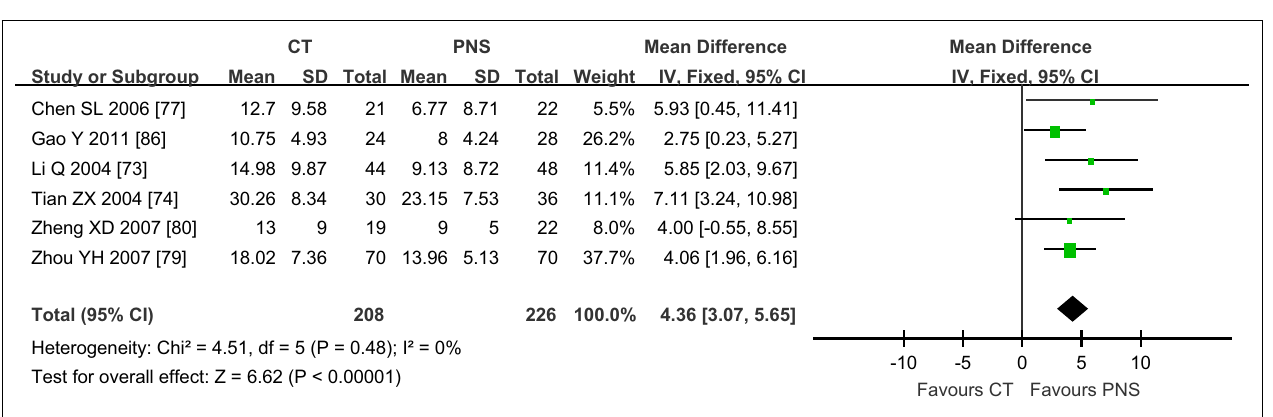
Test for overall effect: Z = 6.62 (P < 0.00001)